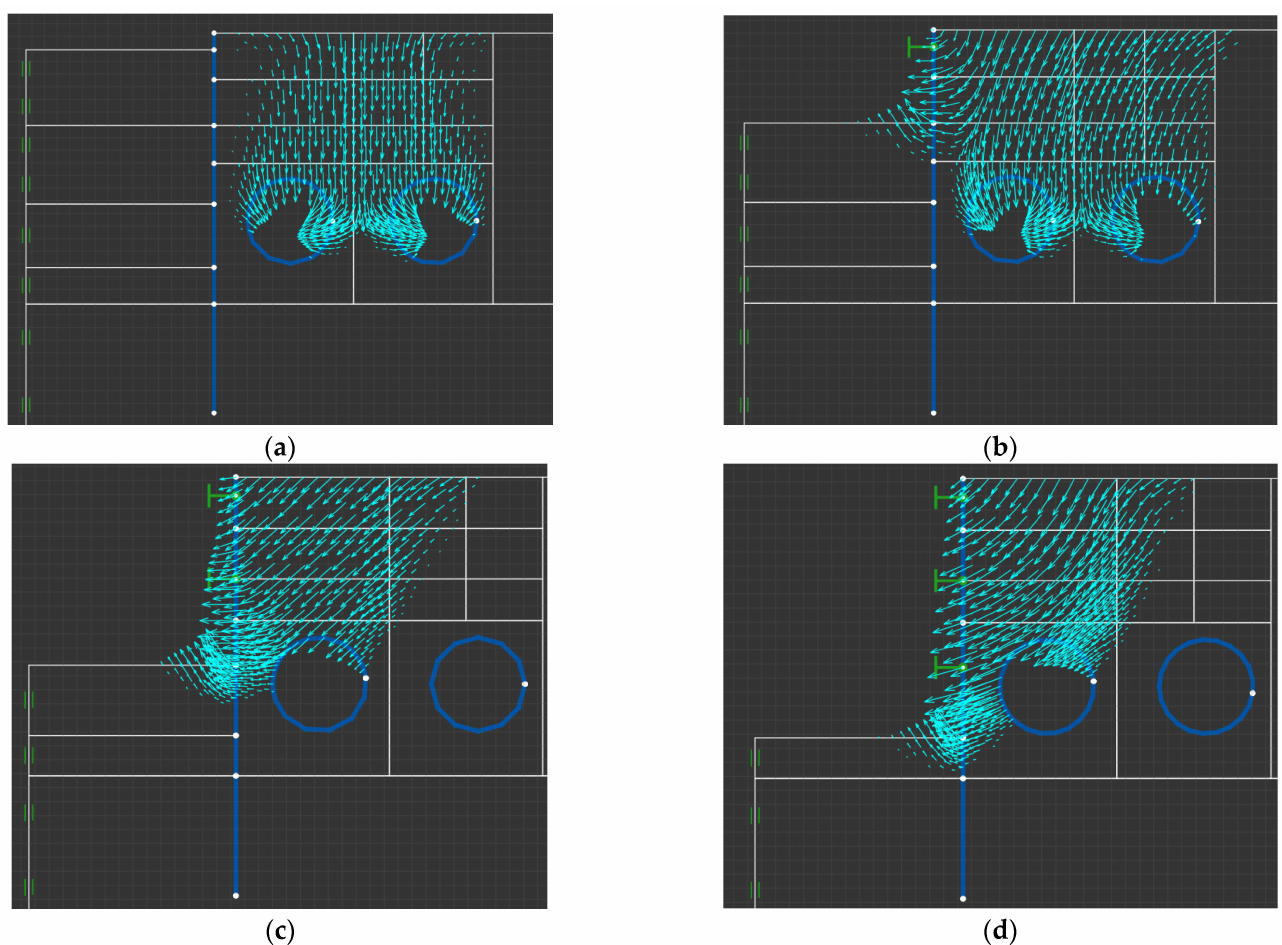
Figure 10. Incremental displacement vector under each stage: ( a ) Stage (1) ( h = 0.08 H), ( b ) Stage (2) ( h = 0.4 H), ( c ) Stage (3) ( h = 0.75 H) and ( d ) Stage (4) ( h = 1.0 H).